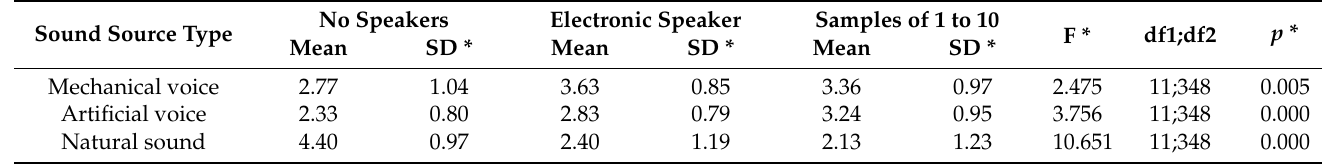
Table 8. Differences in sound source identification between no speakers, samples, and electronic speaker (white noise).